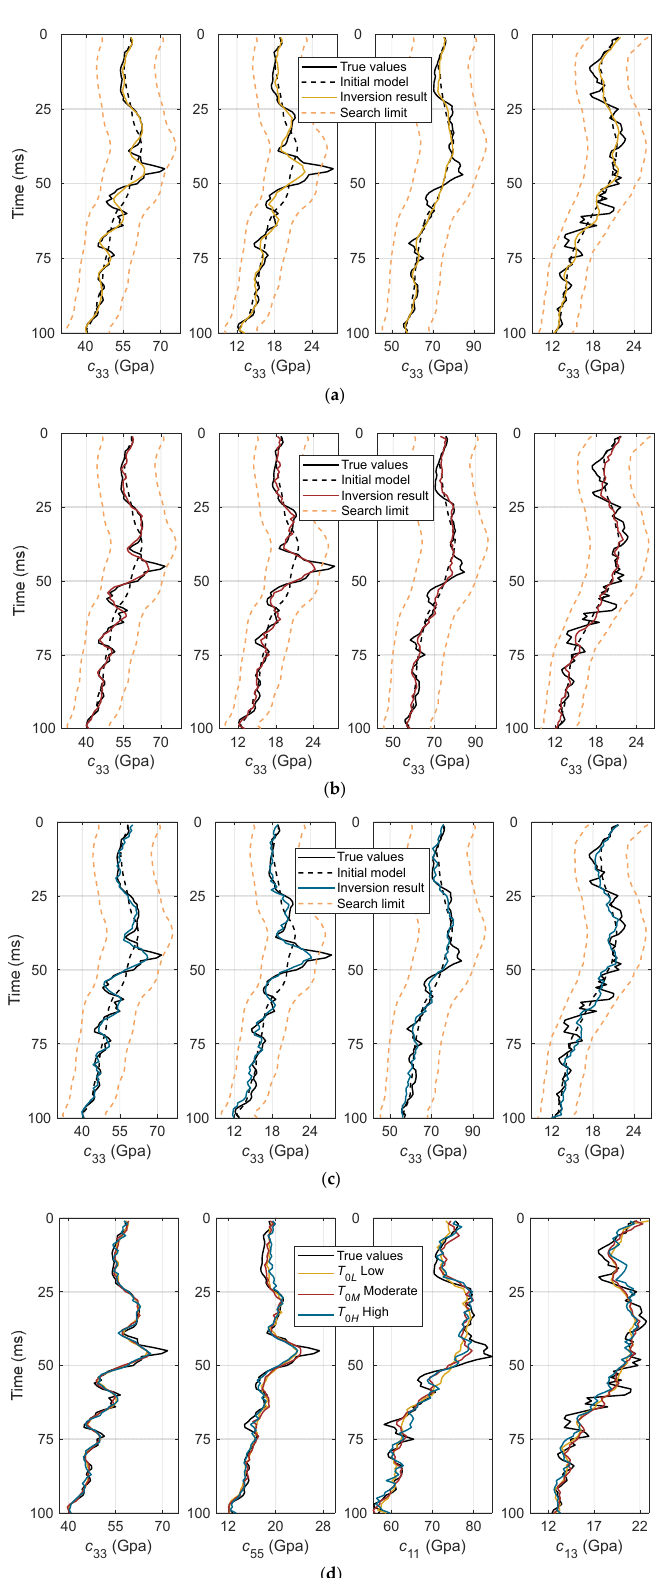
Figure 4. Inversion results with the well model by the FSA optimization at different initial temper- atures: ( a ) the low temperature T 0 L , ( b ) the moderate temperature T 0 M , ( c ) the high temperature T 0 H , and ( d ) the comparison of the three sets of results from ( a ) to ( c ). The black solid, black dash, and orange dash curves are the true logs, the initial models, and the search limits, respectively. The def- initions of inverted curves are given in the legend.